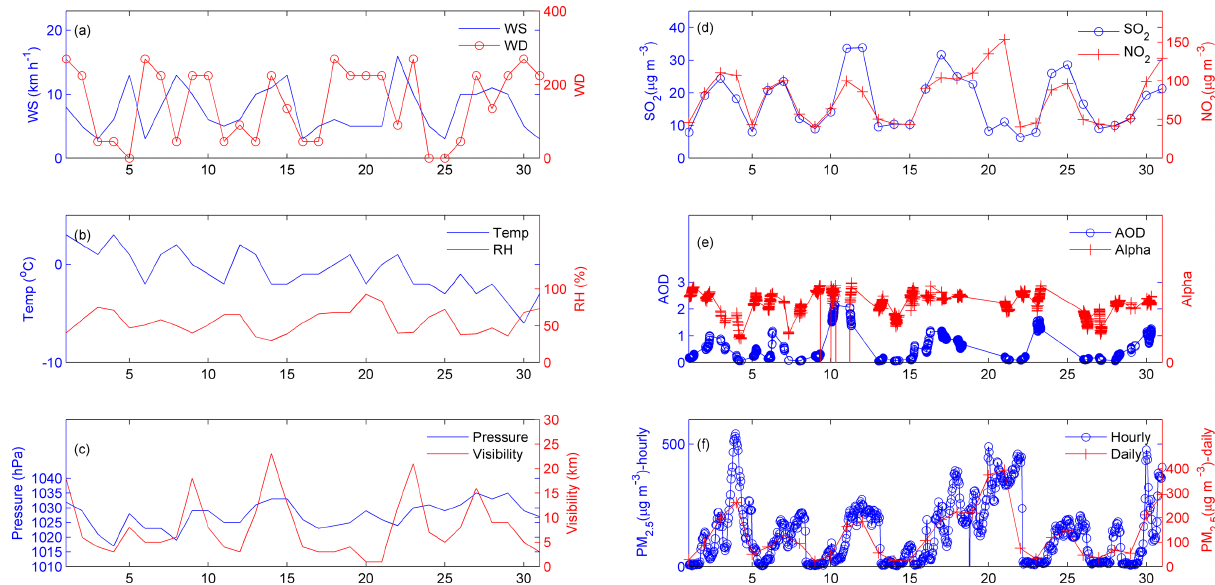
Figure 5. Time series of meteorological parameters and pollutants during December 2016. (a) Wind direction and wind speed (kmh − 1 ), (b) temperature ( ◦ C) and relative humidity (%), (c) atmospheric pressure (hPa) and visibility (m), (d) SO 2 and NO 2 concentration (µgm − 3 ), (e) AOT and Ångström coefficient (440–870nm) (Alpha), and (f) PM 2 . 5 hourly and daily concentration (µgm − 3 ). The atmospheric compo- nents and meteorological data are from https://www.aqistudy.cn/historydata/index.php and